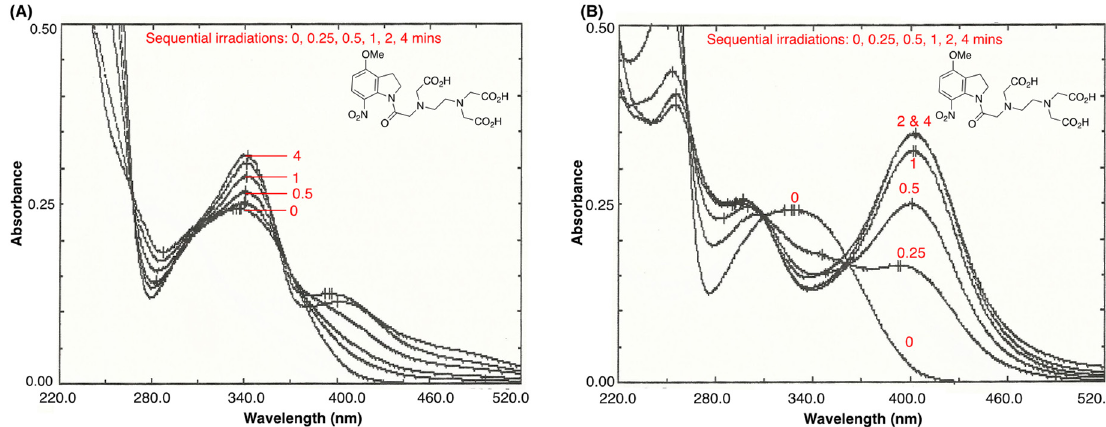
Figure 4. Sequential irradiations of 24. ( A ) plus 2.5 mM EDTA, pH 6.86; ( B ) plus 2.5 mM Ca 2+ ,